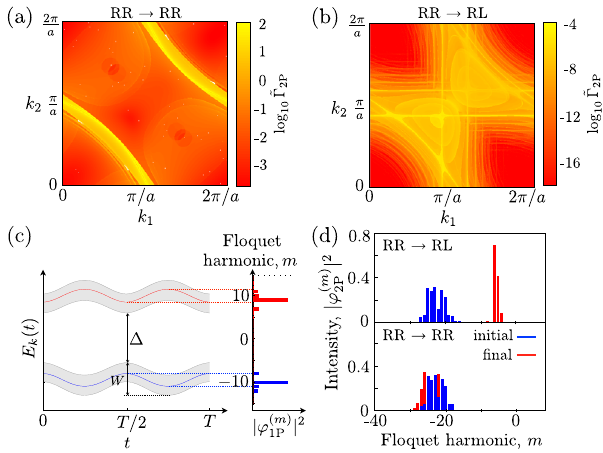
FIG. 2. Two-particle scattering in a partially filled Thouless ~ Γ Γ pump. (a) Intraband scattering rate 2 P ¼ 2 P = ð J 0 L Þ , evaluated for bosons within Fermi ’ s golden rule, Eq. (6), with the forward scattering contribution removed. Here, k 1 and k 2 are the momenta of two incident particles; we take λ ¼ 0 . 66 , ω ¼ 0 . 13 J 0 , and U ¼ 0 . 67 J 0 . (b) Same as above, for interband scattering in which one particle is scattered from the right- to the left-moving band. (c) Single-particle Floquet states. On the left, the shaded region spans the energies of the instantaneous bands as a function of time. The significant Fourier components j φ ð m Þ 1 j 2 ¼ P jh φ ð m Þ 1 j φ ð m Þ 1 ij 2 of a Floquet state α with momentum k fall between P P the minimum and maximum values of the instantaneous energies E α t Þ . (d) Fourier components j φ ð m Þ 2 j 2 ¼ jh φ ð m Þ 2 j φ ð m Þ 2 ij 2 of in- ;k ð P P P coming and outgoing two-particle Floquet states. For intraband scattering (bottom), the Fourier components overlap. For inter- band scattering (top), the overlap is strongly suppressed, leading to a suppression of the interband scattering